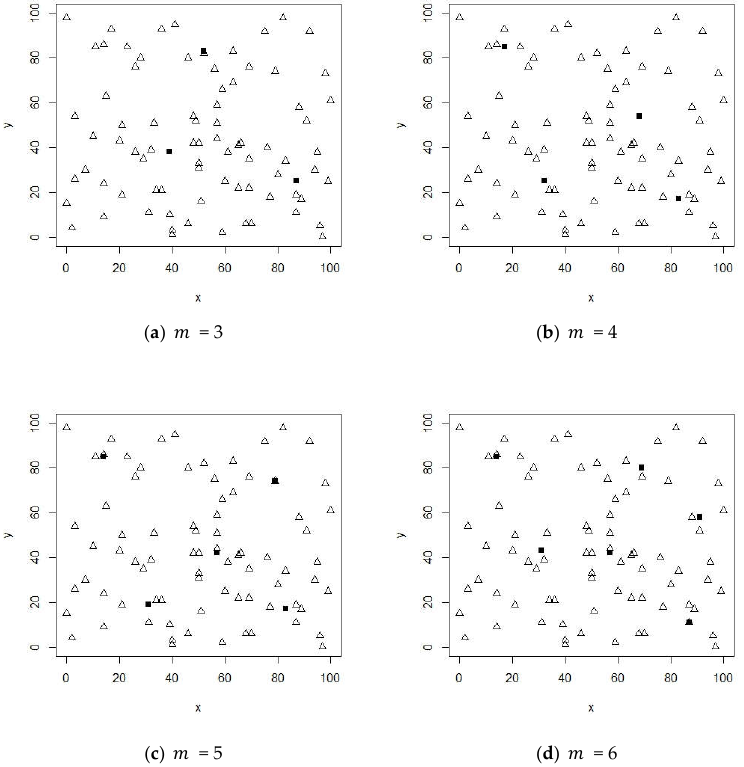
Figure 5. Globally optimal facility locations in the planning area for Instance 26. ( a )  = 3; ( b )  = 4; ( c )  = 5; ( d )  = 6.